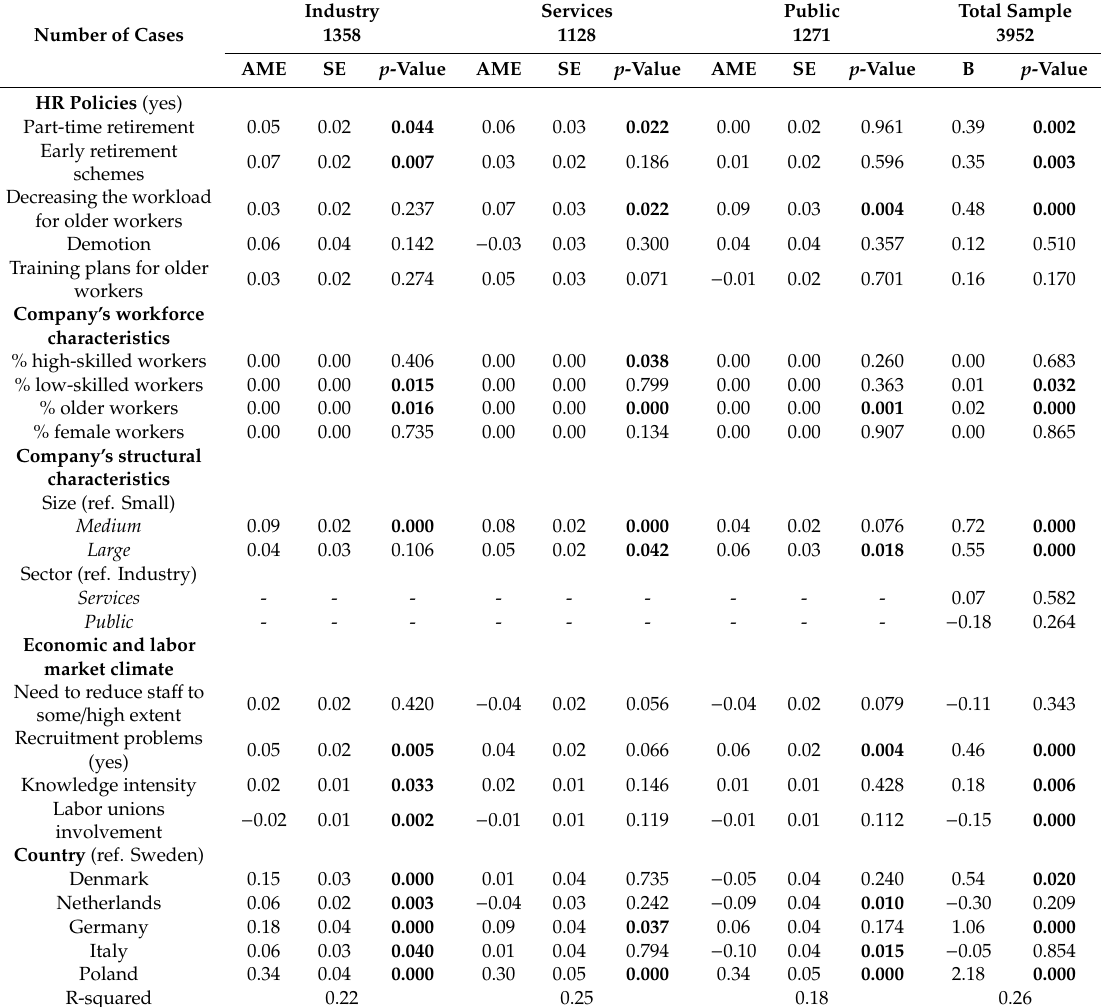
Table 4. Explanatory variables for recruiting employees who already retired, by sector and total